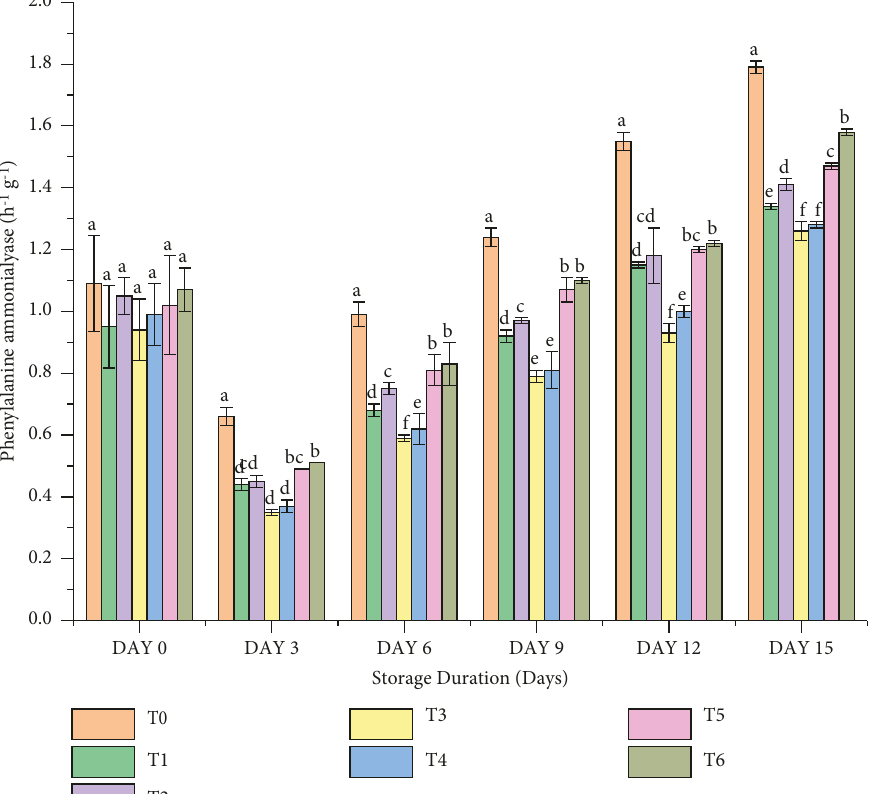
Figure 7: Effect of chitosan coating and cinnamon essential oil on phenylalanine ammonia lyase of pomegranate arils during storage at 4 ± 1 ° C. Vertical bars represent the mean ± SD of 3 replicates. Error bars with different letters on the same storage period show a significant difference ( P ≤ 0 . 05). T0 � control; T1 � 1% chitosan+0.25% oil; T2 � 1% chitosan+0.5% oil; T3 � 2% chitosan+0.25% oil; T4 � 2% chitosan+0.5% oil; T5 � 3% chitosan+0.25% oil; T6 � 3% chitosan+0.5%